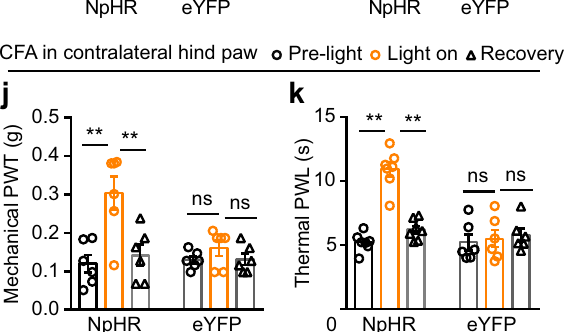
g – i Effect of silencing of the STN – LPB projection on PWT and PWL 15min and 45min after injection of capsaicin into hind legs. n ≥ 6 per group. g Baseline PWT, t =0.99, P =0.34; h F P =0.0011;( i ) F P <0.0001. j , k Effect (1,11) =19.02, (1,11) =61.07, of silencing of the STN – LPB projection on PWT ( F (2, 22) = 8.13, P =0 . 00 2 5) and PWL ( F (2, 22) = 9.96, P =0 . 001) 24h after CFA injection in hind paws. n ≥ 6 per group. i – m Effect of silencing of the STN – LPB projection on PWT ( F (2, 28) = 14.44, F P <0.0001)2weeksafterSNIsurgery. n =8per P <0 . 0001)andPWL( (2,28) =17.24, group. * P <0.05. ** P <0.01; Two-way ANOVA with Tukey ’ s post-hoc analysis for ( c – f )and( h – m );Two-tailedpaired t testfor( g